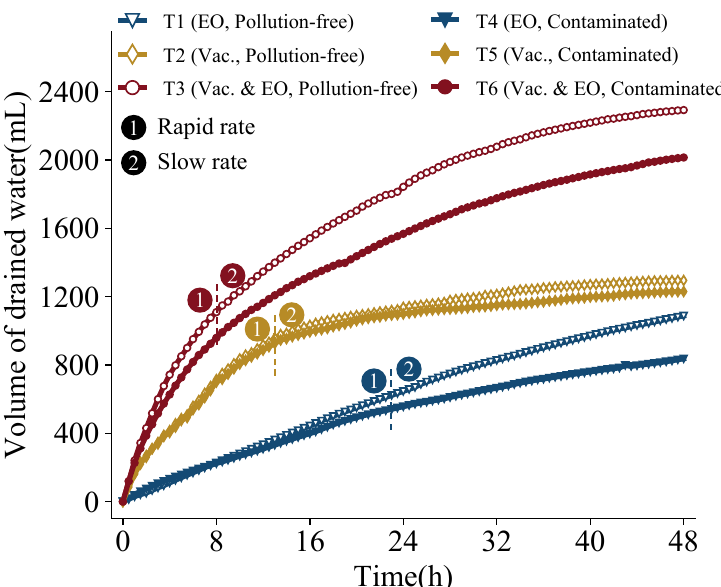
Figure 4. Change curve of the volume of drained water with